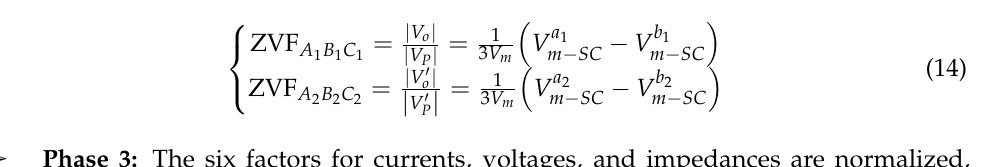
Phase 3: The six factors for currents, voltages, and impedances are normalized, according to the formulations in